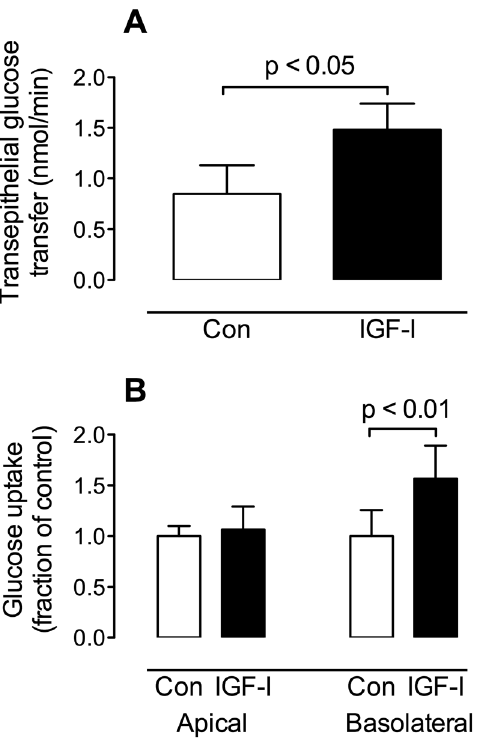
Figure 2. GLUT1 transport and IGF-I in BeWo cells. (A) Transepithelial transport : BeWo cell monolayers plated on permeable inserts were treated for 24 hr. with 200 ng/ml IGF-1 following serum- starvation. Measurements of the transepithelial transport of glucose were performed in the presence and absence of 2 mM phloretin (see Methods). Transcellular transport was calculated as the phloretin- inhibitable fraction of transepithelial transport. The results showed that treated cells had an increased rate of transcellular glucose transport (p , 0.05, paired t test, n=4). (B) Cellular uptake : BeWo cell monolayers plated on permeable inserts were serum starved then treated for 24 hr. with 200 ng/mL IGF-1. Following treatment, uptake of [ 3 H] 2-deoxy–D- glucose into the cells across the apical or basolateral face was measured. The rate of glucose uptake across the apical face was not altered by IGF-I treatment. The rate of uptake across the basolateral face was increased by IGF-I treatment (p , 0.01, paired t test, n=4).